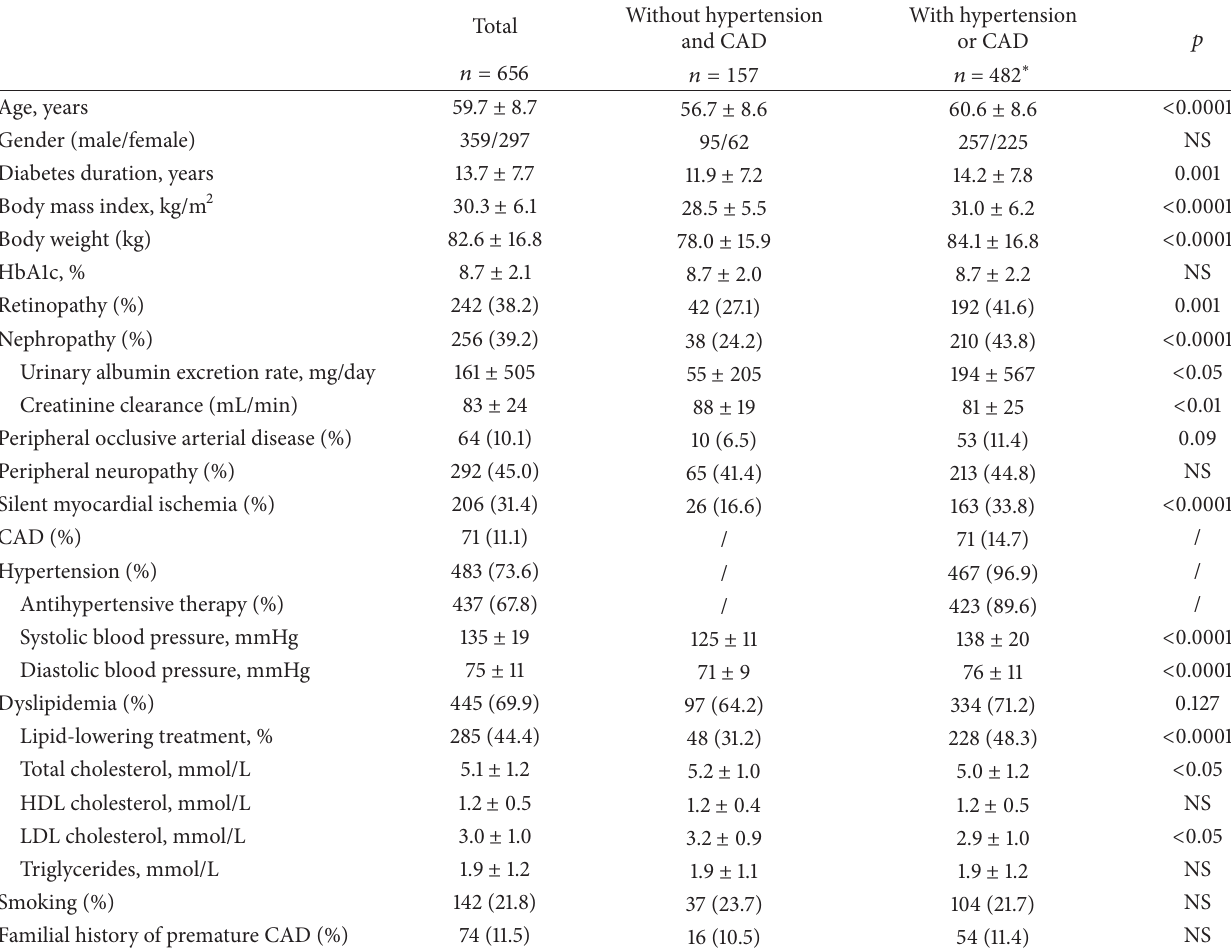
Table 1: Characteristics of the total cohort of type 2 diabetic patients, of those without hypertension and coronary artery disease, and of those with hypertension or coronary artery disease.